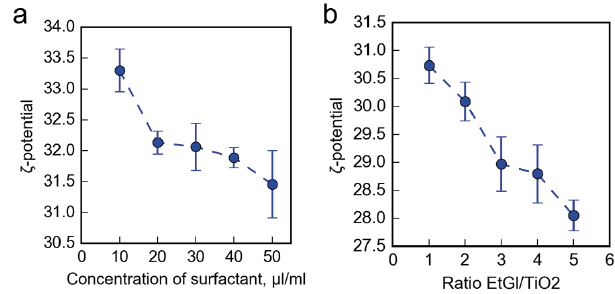
Figure A7. Zeta potential of inks with the addition of a surfactant ( a ) and ethylene glycol ( b ).